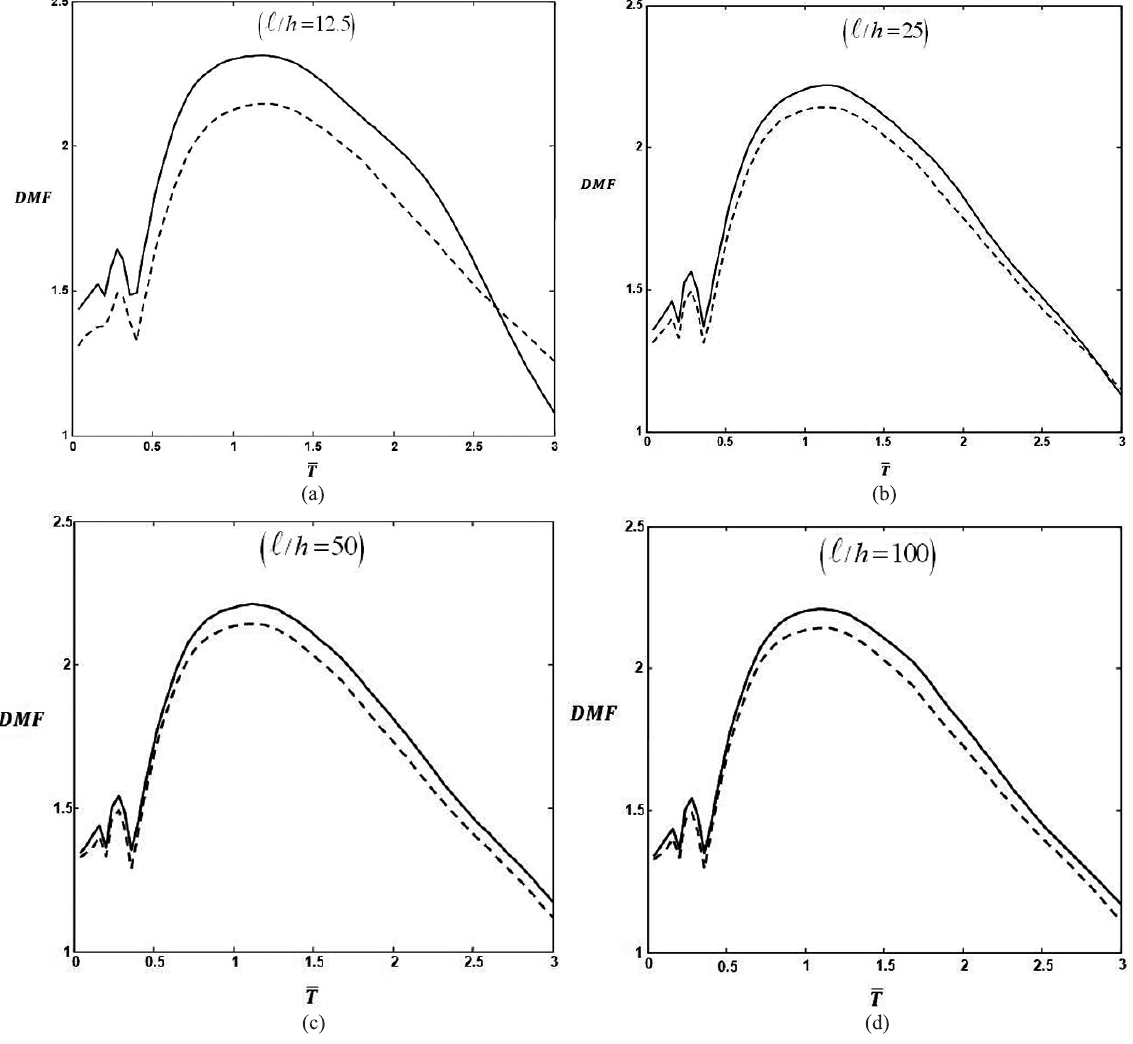
Fig. 7. Effect of shear deformation on the DMF vs. T for different slenderness ratio (—— FSDT; – – – – CLT) m sec, k = 10 9 m = 0 . 1 kg, v = 5